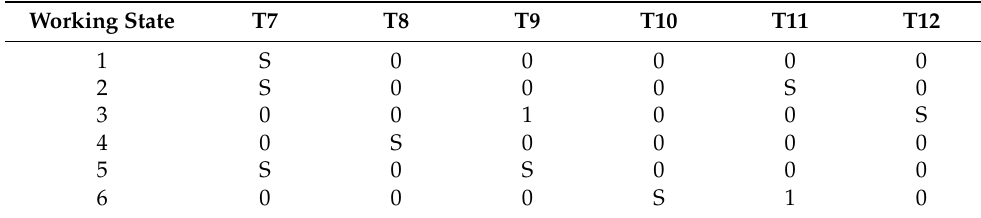
Table 2. The working state of the main electrical circuit.